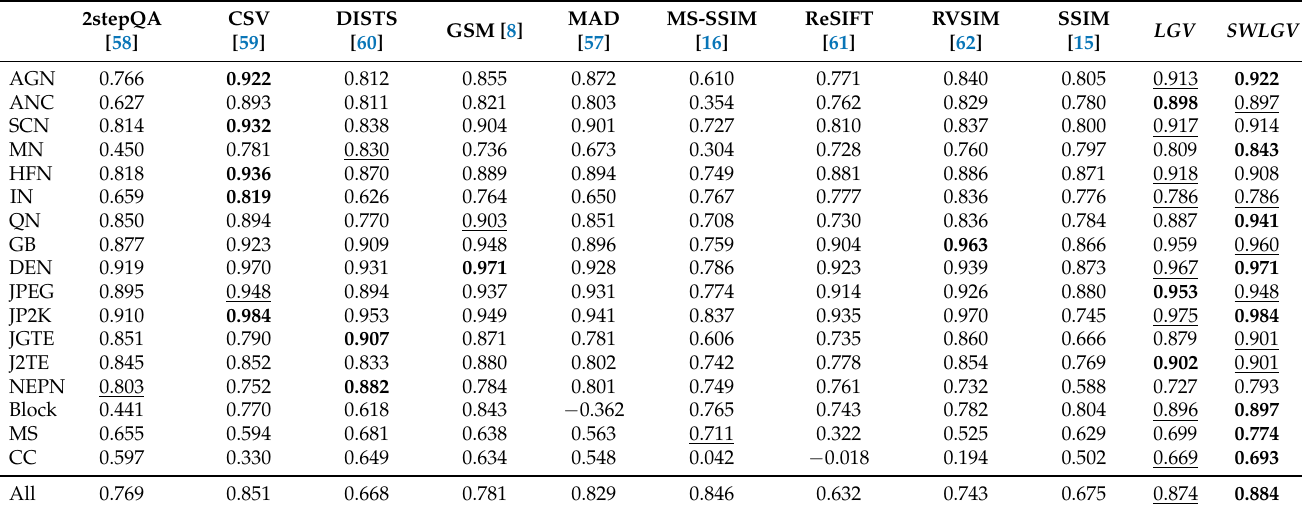
Table 8. Comparison on TID2008’s [56] distortion types. SROCC values are given. The highest values are typed in bold , while the second highest ones are